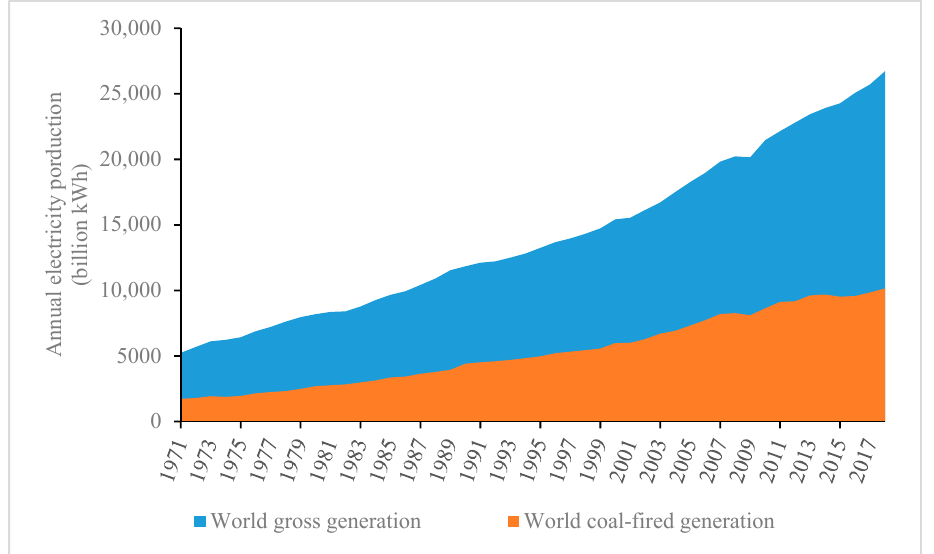
Figure 1. World gross generation and world coal-fired power generation from 1971 to 2018 (data source: World Bank/International Energy Agency).